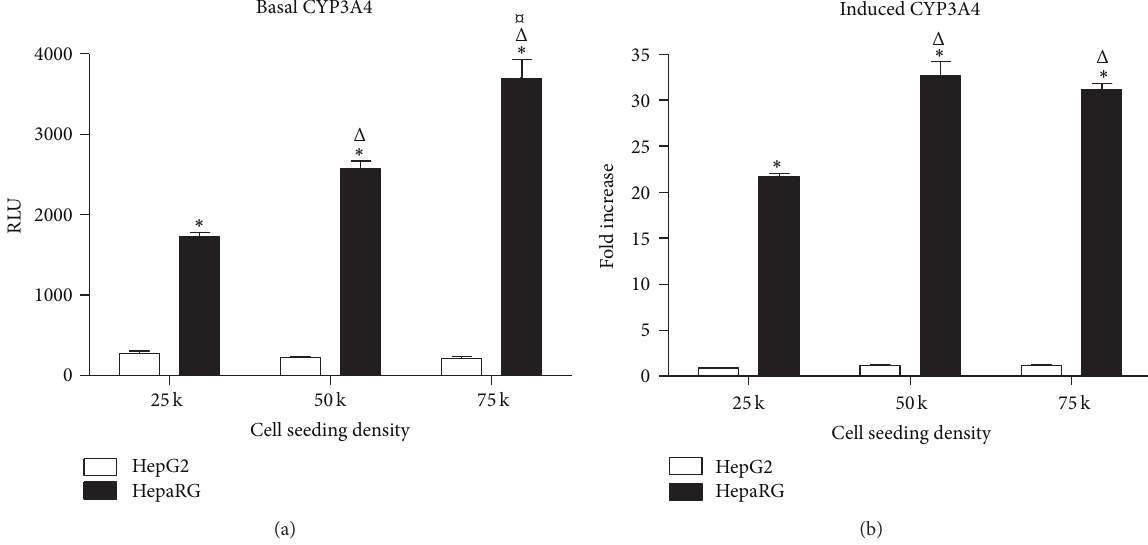
Figure 2: Basal and induced CYP3A4 activity in HepaRG and HepG2 cells. (a) Basal CYP3A4 activity of HepaRG and HepG2 cells plated in 96-well collagen-coated plates at seeding densities of 25,000, 50,000, and 75,000 cells per well and cultured for 72 hours. Data represent mean ± SEM for 3 independent experiments. ∗ represents 𝑃 < 0.05 versus HepG2 cells at the same seeding density; Δ represents 𝑃 < 0.05 versus HepaRG cells seeded at 25,000 cells per well; ¤ represents 𝑃 < 0.05 versus HepaRG cells seeded at 50,000 cells per well. (b) CYP3A4 induction in HepaRG and HepG2 cells plated in 96-well plates at seeding densities of 25,000, 50,000, and 75,000 cells per well and treated with DMSO (0.1%) or rifampicin (RIF, 10 𝜇 M) for 72 hrs starting at Day 3 in culture. Data represent mean ± SEM for 3 independent experiments. ∗ represents 𝑃 < 0.05 versus HepG2 cells at the same seeding density; Δ represents 𝑃 < 0.05 versus HepaRG cells seeded at 25,000 cells per